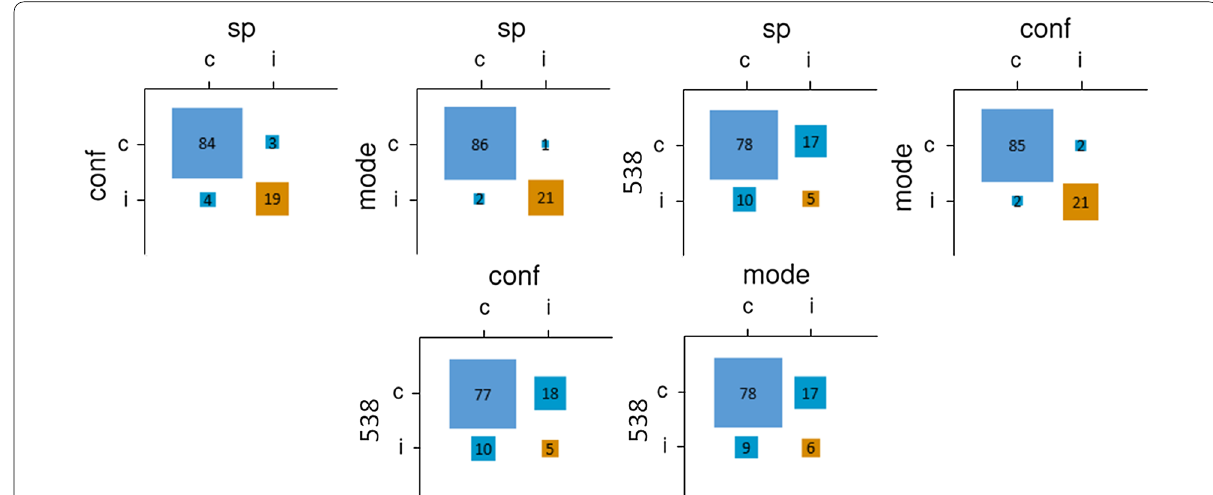
surprisingly popular; conf =